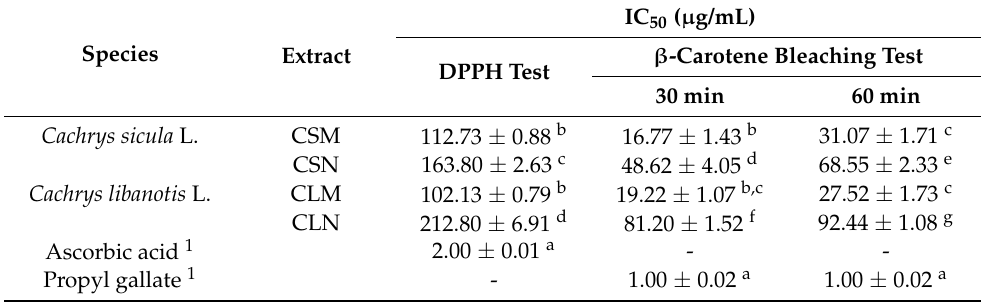
Table 5. Antioxidant activity of Cachrys libanotis L. and Cachrys sicula L. extracts.